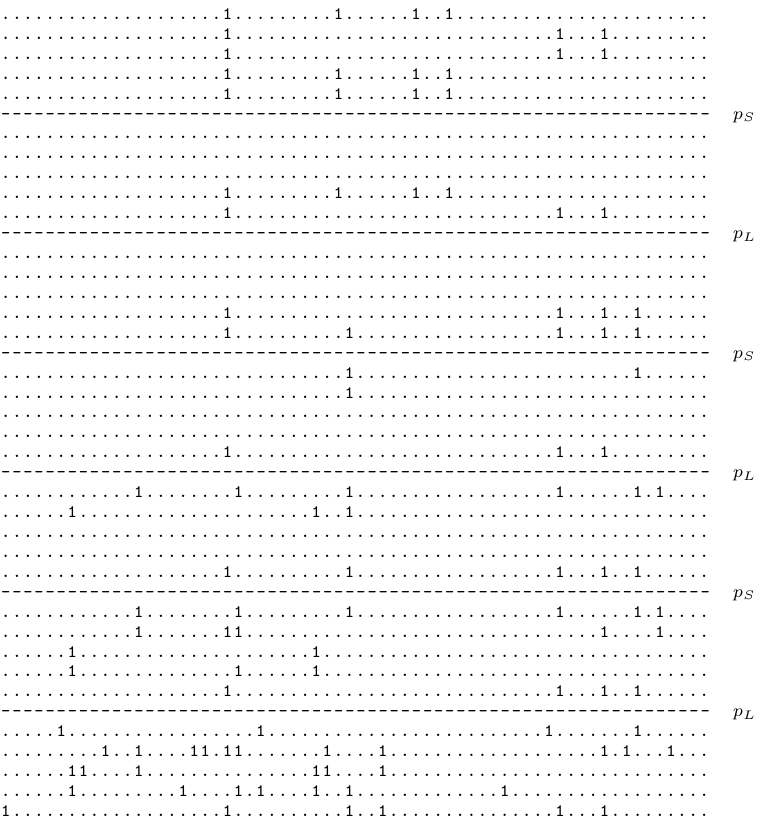
Figure 7: 4-round trail with 44 [6, 5, 10, 23] active Sboxes and weight 123 [13, 15, 25,